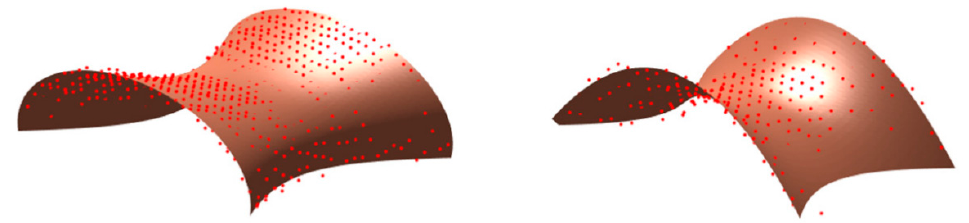
Figure 4. Fits of necks/bridges between neighbouring particles with a one-sheet hyperboloid (left) and a hyperbolic paraboloid (right).